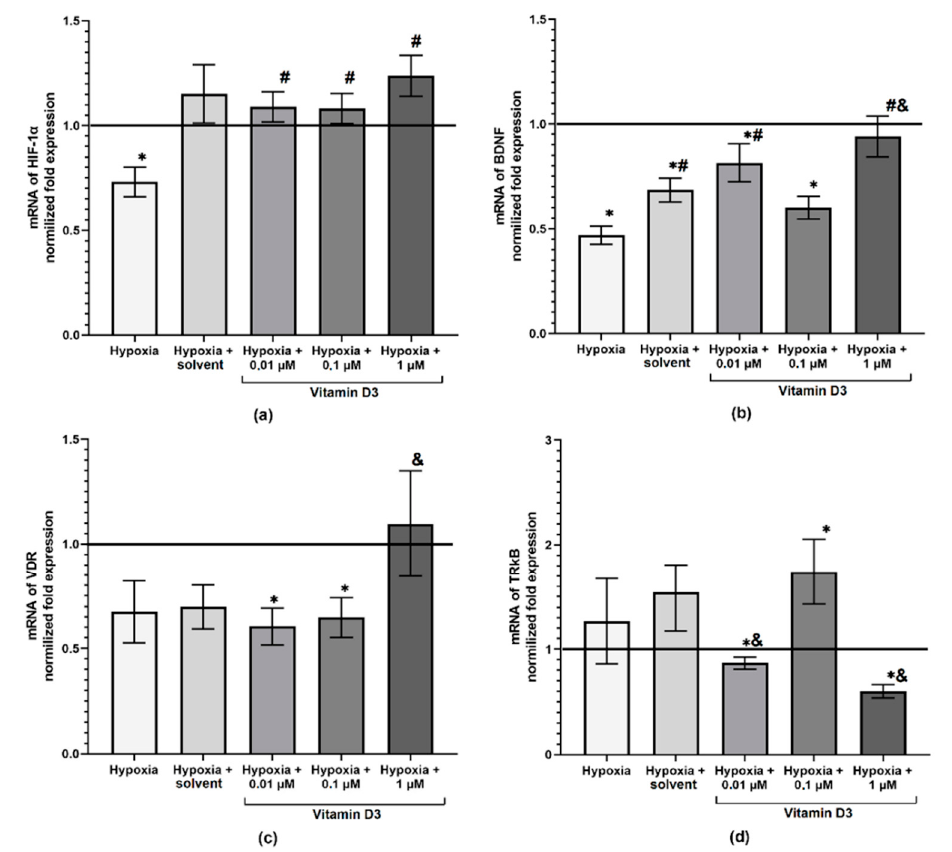
Figure 5. The level of transcription factor HIF-1 α ( a ) and neurotrophic factor BDNF ( b ) genes expression in primary neuronal cultures cells 24 h after hypoxia modeling. Data are normalized to the reference gene (Oaz1), * versus “Sham”, # versus “Hypoxia”, & versus “Hypoxia + solvent”, p < 0.05, one-way ANOVA and Tukey post hoc test.